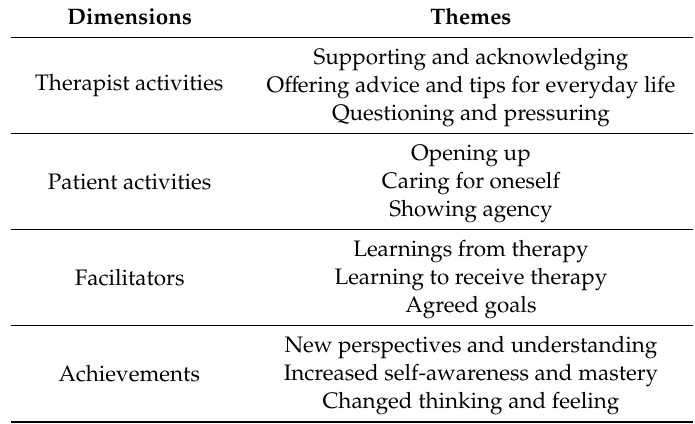
Table 1. Dimensions and themes promoting improvement in time limited psychodynamic psychotherapy (PDT) for